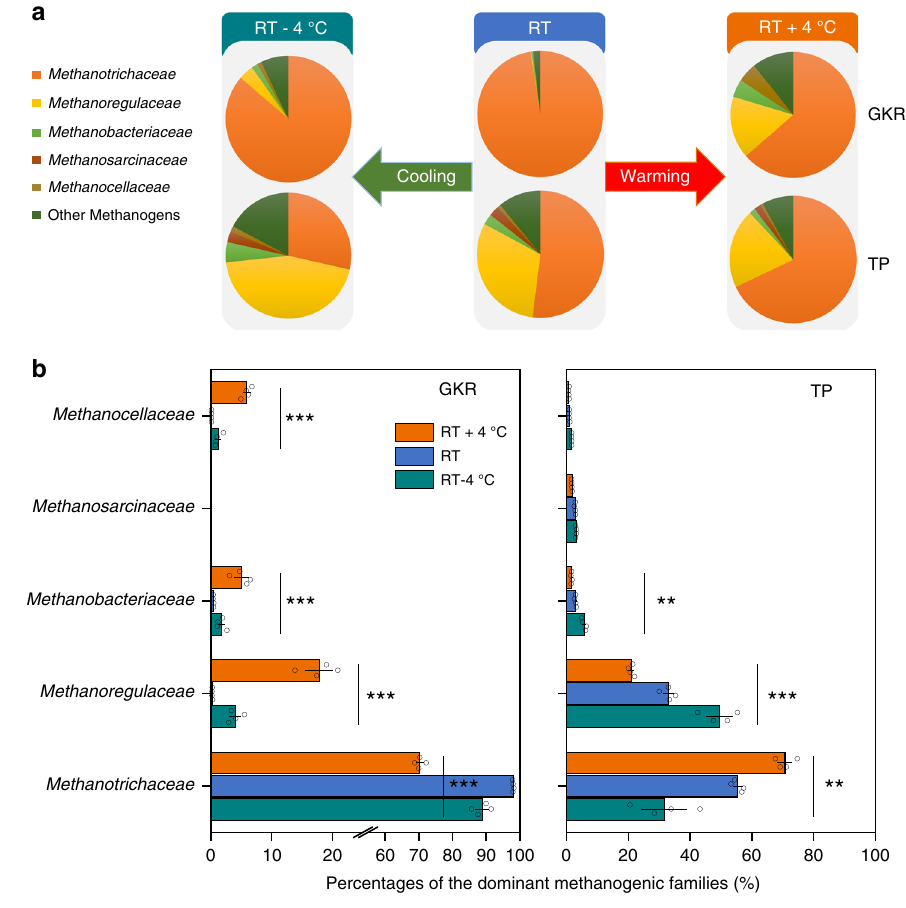
Fig. 3 Changes in methanogenic community. a Shifts in methanogenic community composition under experimental warming or cooling by 4 °C. b Mean percentages of the dominant methanogenic archaea and their differences among the studied thermal treatments. RT, reference temperature (12°C). GKR, the Greater Khingan Range; TP, the Tibetan Plateau. ** P < 0.001; *** P < 0.0001. Ordinary one-way ANOVA for comparing the three thermal treatments. Data are presented as mean values ± SEM in b , n = 4 independent soil samples.